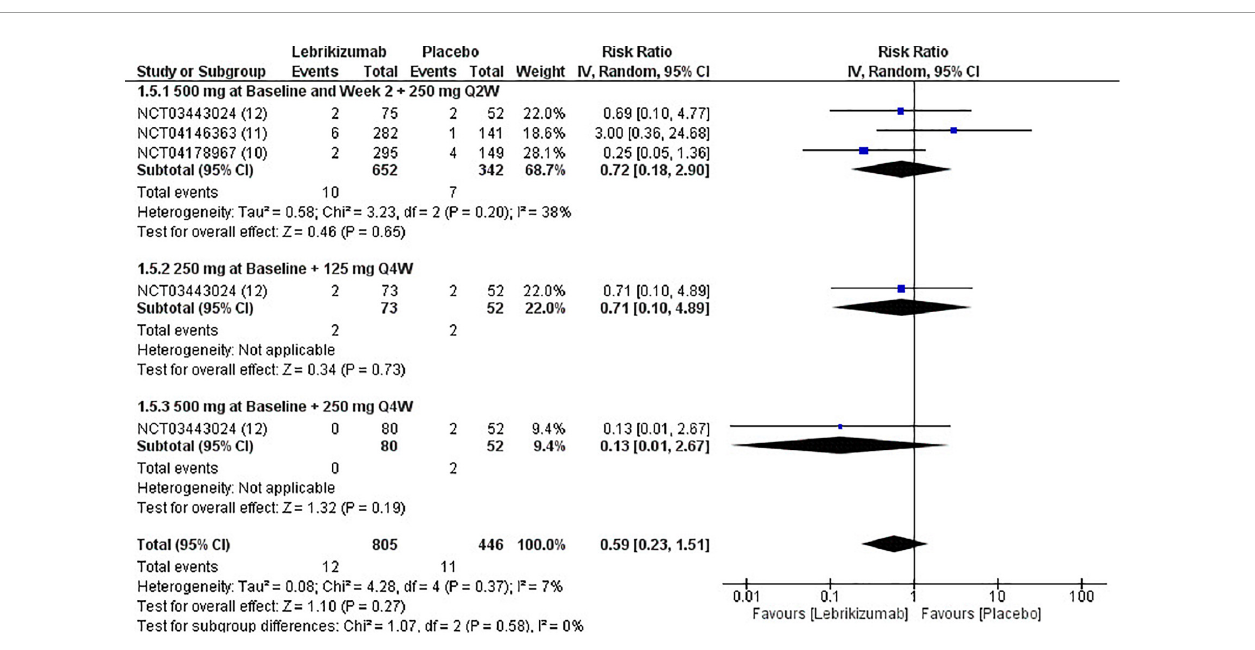
associated only with this event (RR = 0.17, 95% CI [0.01,